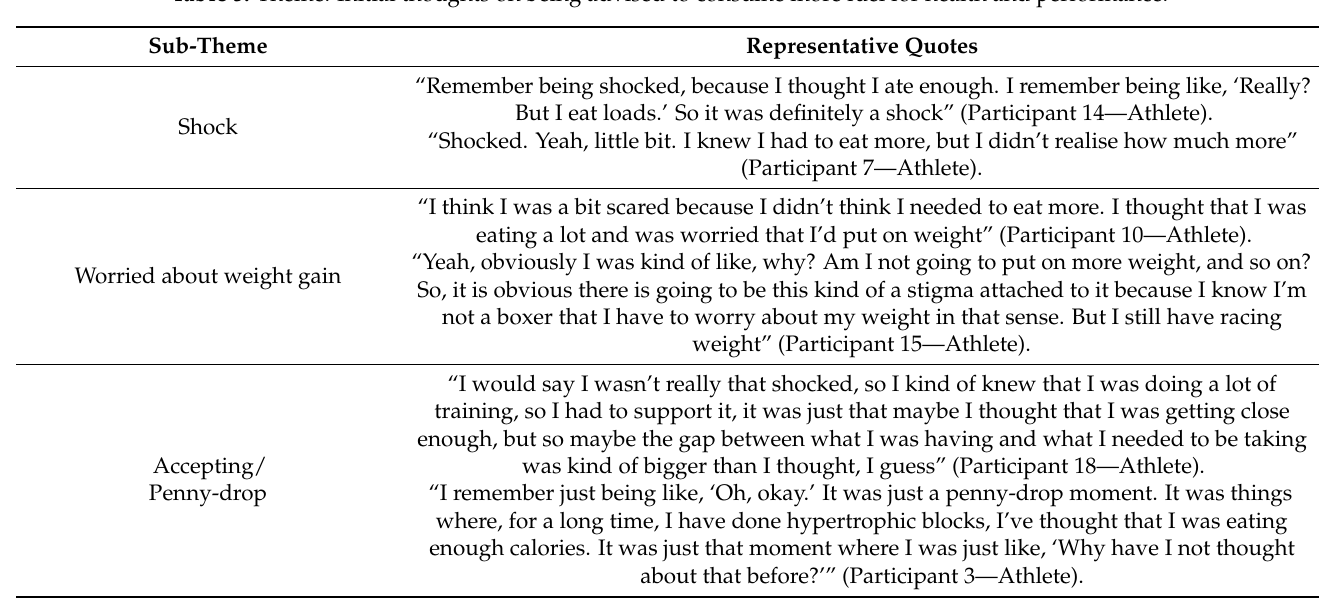
Table 5. Theme: Initial thoughts on being advised to consume more fuel for health and performance.